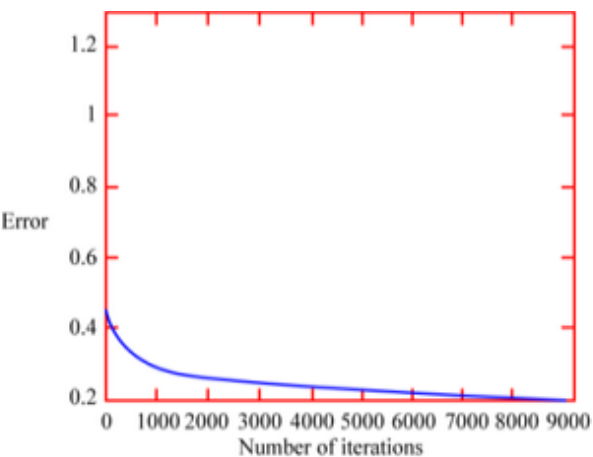
Figure 9. The training error variation curve of the DBN